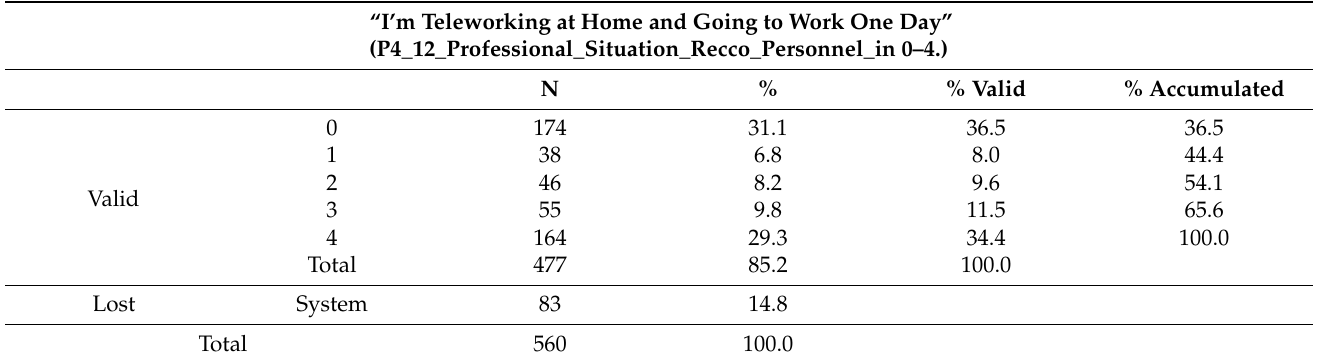
Table 5. People who do not use telework at all and people who telework completely (values 0 and